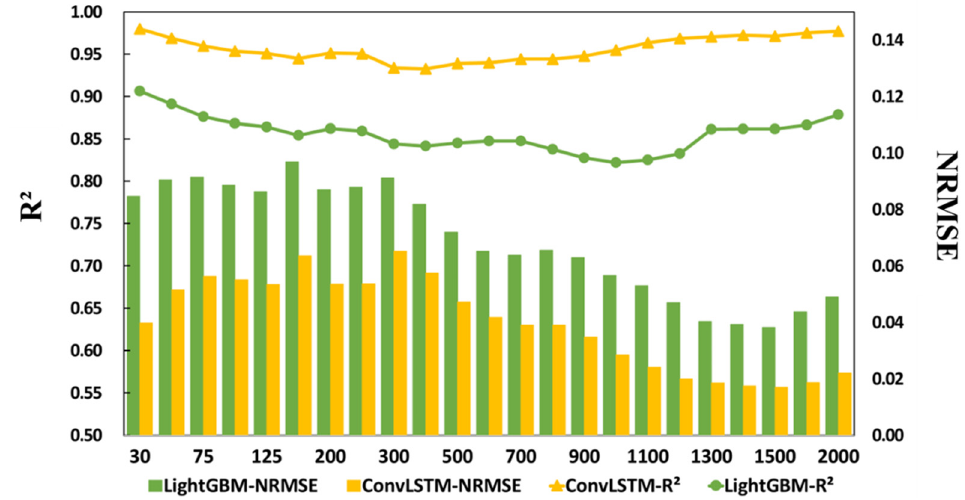
Figure 3. The R 2 and NRMSE for ConvLSTM and LightGBM validated by EN4-Profile dataset at different depth levels.